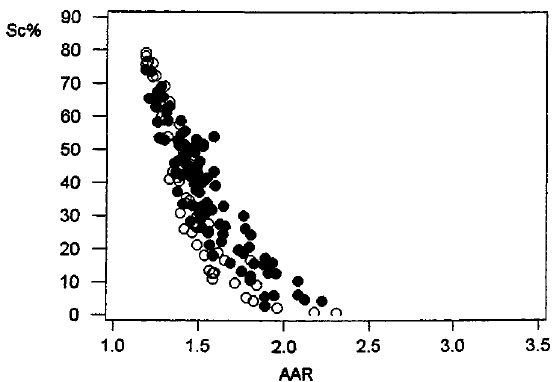
Fig. 6. Comparison of the distribution of AAR (average absorption ratio, see text) vs. Sc% (condensed chromatin area) values between